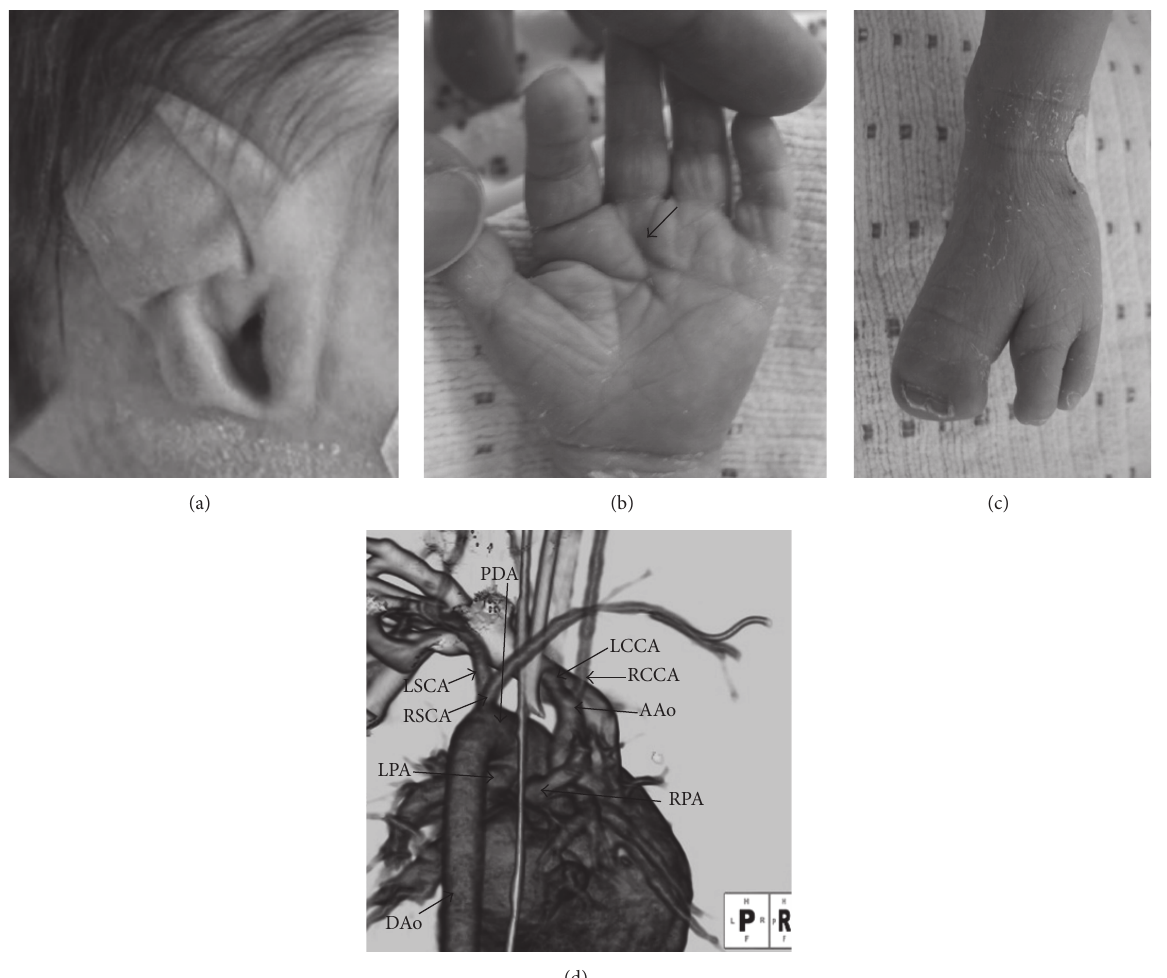
Figure 1: Dysmorphic features and cardiovascular malformations in Case 1. (a) “CHARGE ear.” (b) Hockey-stick palmar crease (arrow). (c) Cleft foot. (d) 3D-CT angiography showed truncus arteriosus type A4, interrupted aortic arch type B, and aberrant origin of the right subclavian artery. AAo, ascending aorta; DAo, descending aorta; LCCA, left common carotid artery; LPA, left pulmonary artery; LSCA, left subclavian artery; PDA, patent ductus arteriosus; RCCA, right common carotid artery; RPA, right pulmonary artery; RSCA, right subclavian